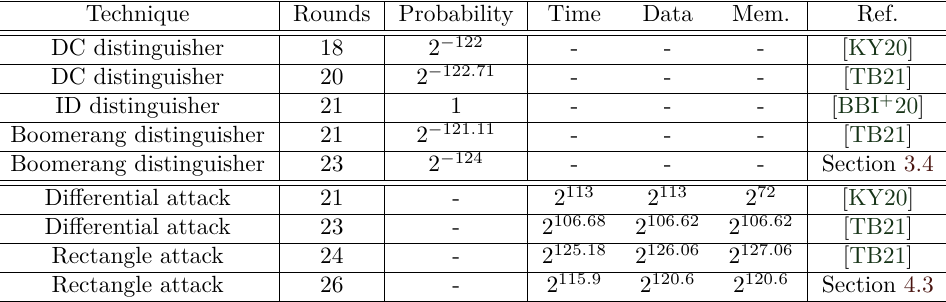
Table 1: Complexities of the existing results on WARP . Note that for all the distinguishers presented here we can add 2 rounds for free, see Section 3.4. ID = Impossible Differential, DC = Differential Characteristic.